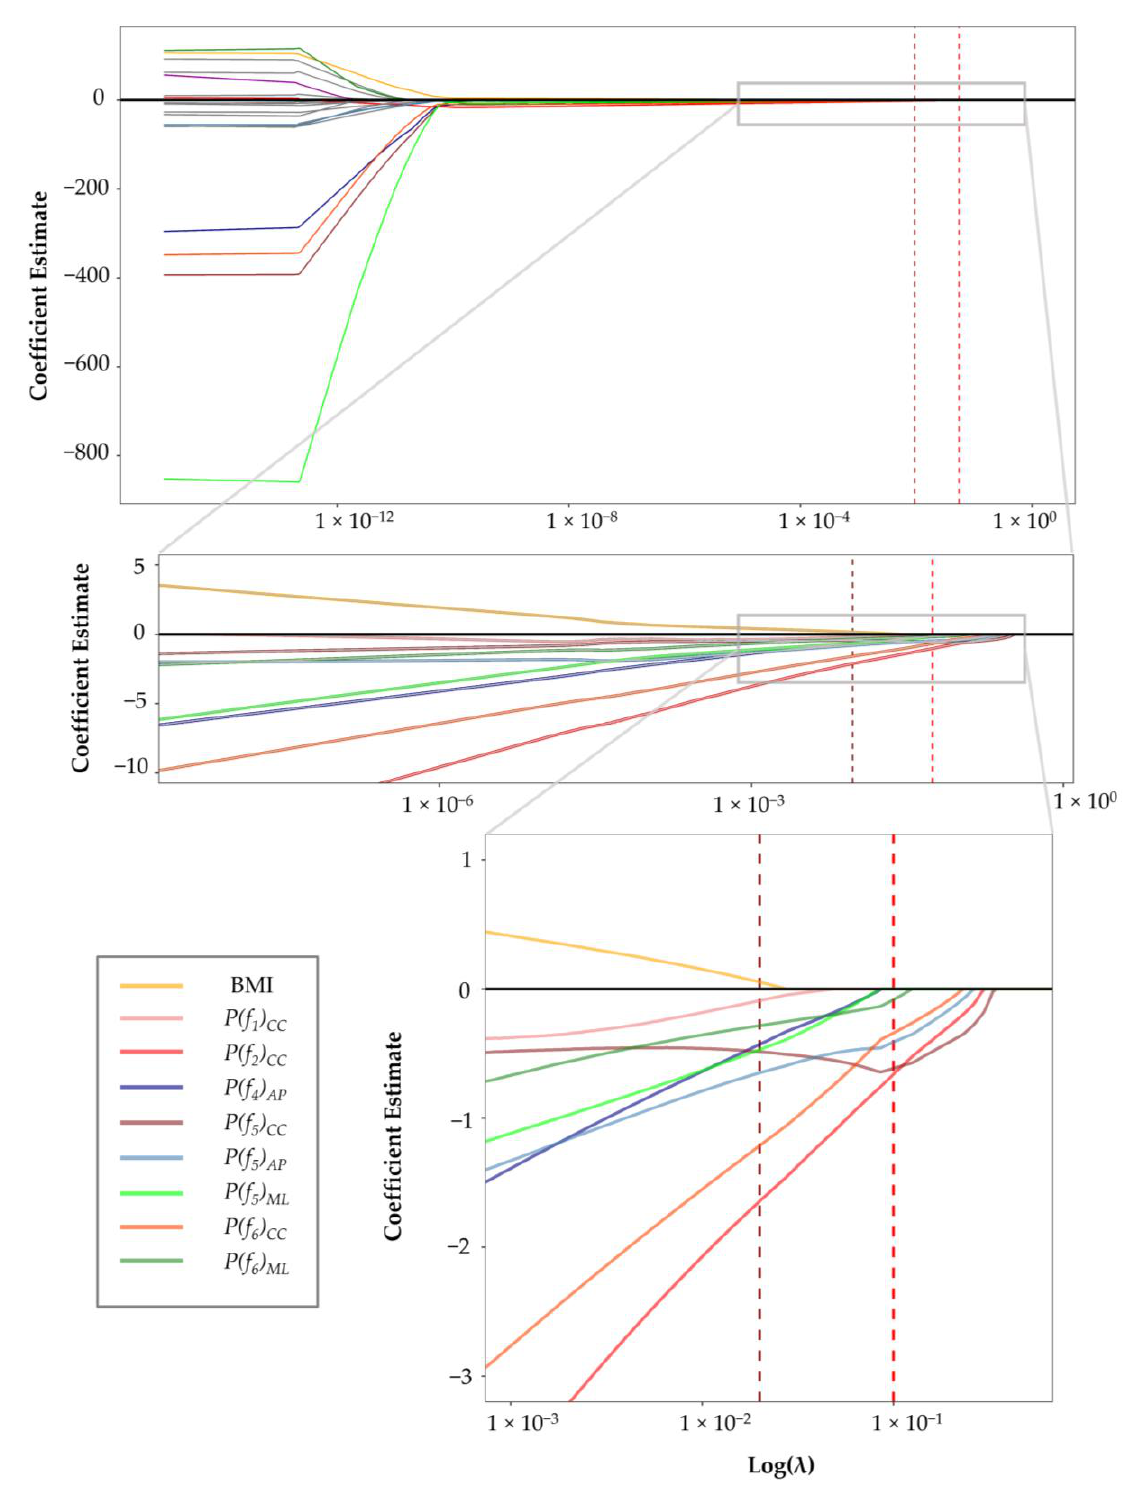
Figure 3. LASSO regression coefficient profile of the variables over different values of the penalty parameter ( λ ). Two vertical dashed lines demonstrate the values corresponding to λ min (dark red), defined as the penalty value with minimum binomial deviance, and λ 1se (light red), defined as the largest penalty parameter within one standard error of the minimum binomial deviance.